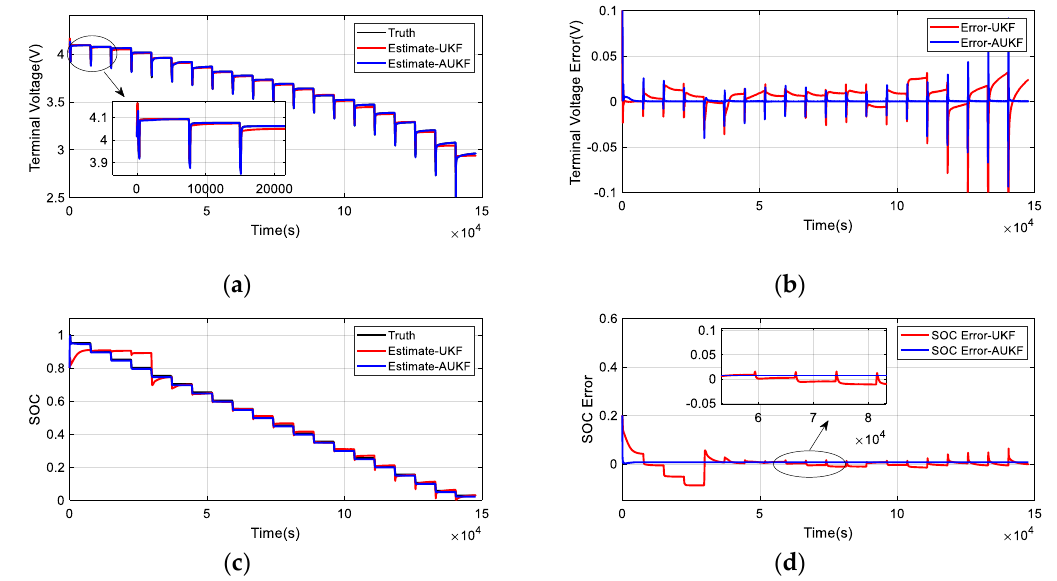
Figure 16. For the initial SOC = 0.8, the comparison of the estimation results of the UKF algorithm and the AUKF algorithm under pulsed discharge conditions. ( a ) Comparison of terminal voltage. ( b ) Comparison of terminal voltage errors. ( c ) Comparison of SOC. ( d ) Comparison of SOC errors.